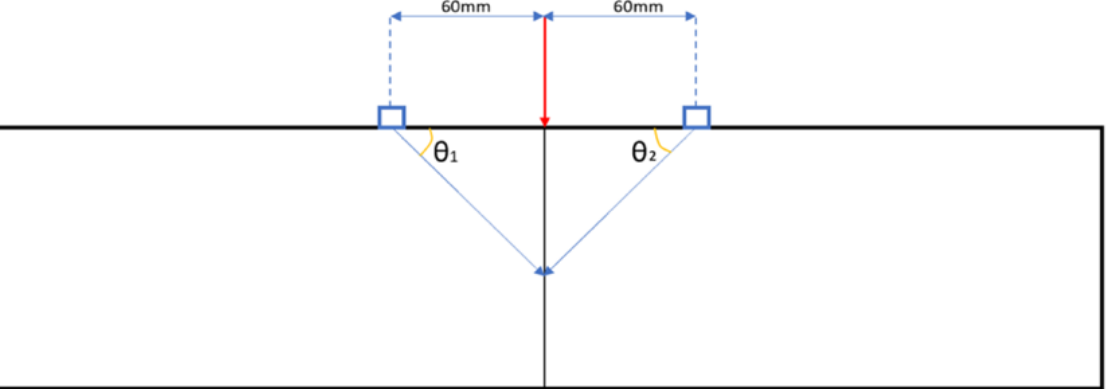
Figure 8. Hodogram crack location method.